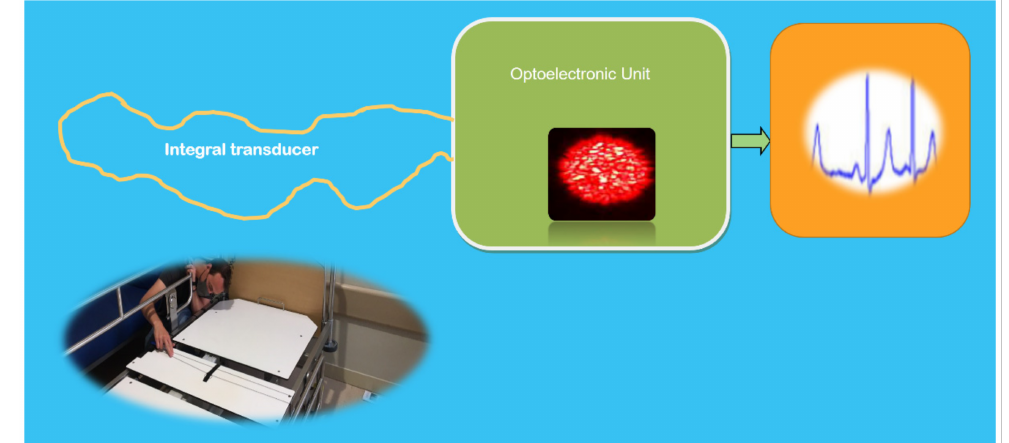
Figure 9. Schematic illustration of an integral specklegram based sensor for non-contact monitoring of vital signs of humans on/in bed. Monochromatic light is injected in the multimode POF fiber with a length lower than the laser coherence length. A low-cost tiny CCD device detects the speckle image at the end of the fiber. The changes in the intensity of successive speckle frames are functioning on the fiber perturbation. Their treatment with appropriate further processing drives to the time-dependent HR signal. In the inset, below left, is shown a view of installing one of these sensors on a bed (below the mattress) the service of Cardiology of the Hospital Universitario Marqu é s Valdecilla del SCS en Santander, Spain. Courtesy of the